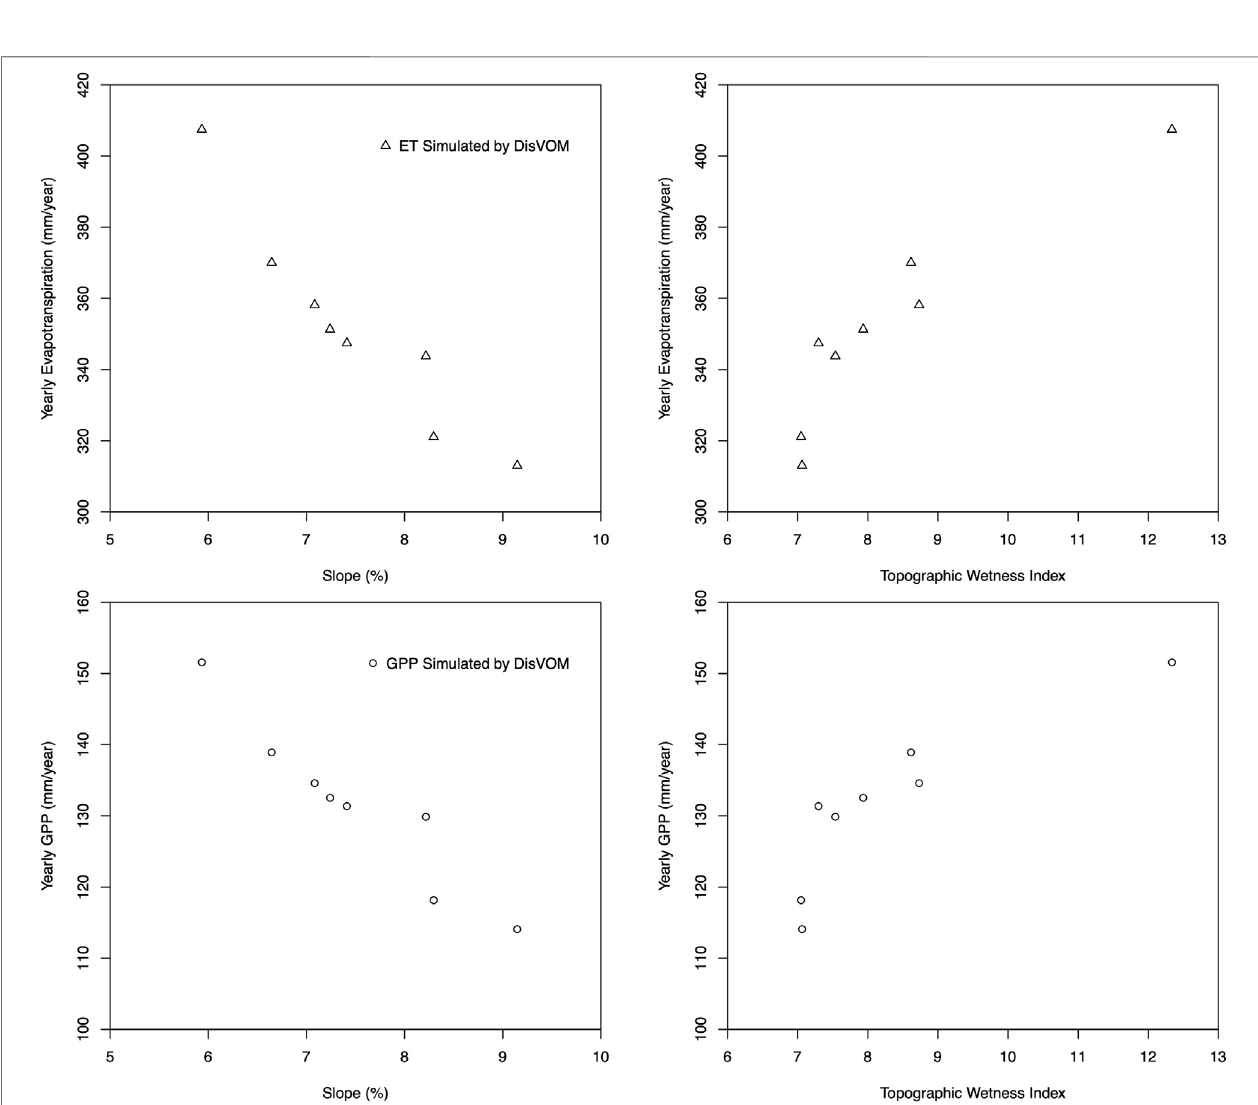
FIGURE 12 | Correlation of annual ET and GPP with slope and TWI. Frontiers in Environmental Science |